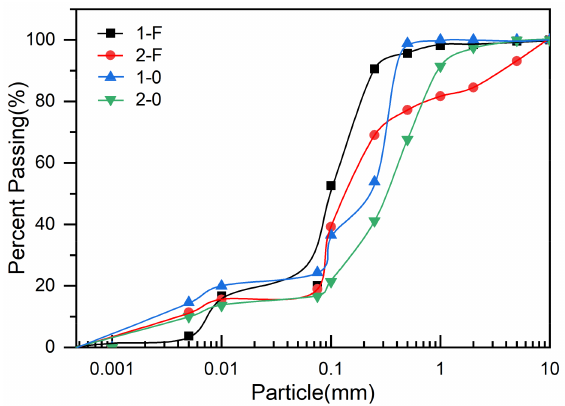
Figure 2. Grading curve.